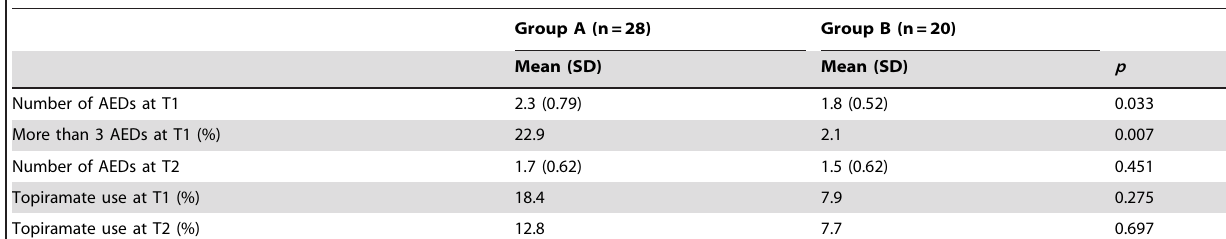
Table 2. AED use in Groups A and B.